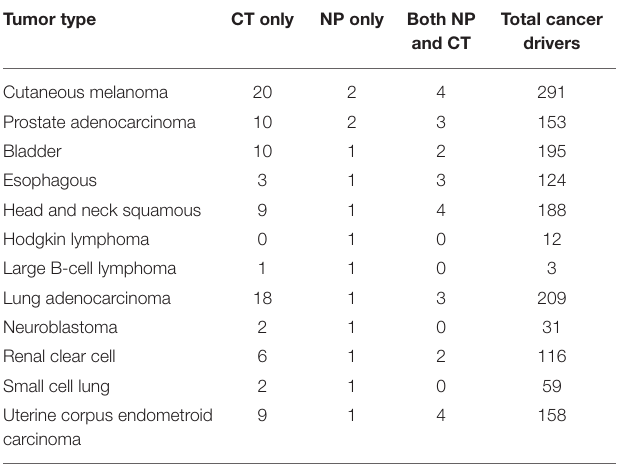
TABLE 6 | Natural products improve coverage of cancer drivers across cancer types.